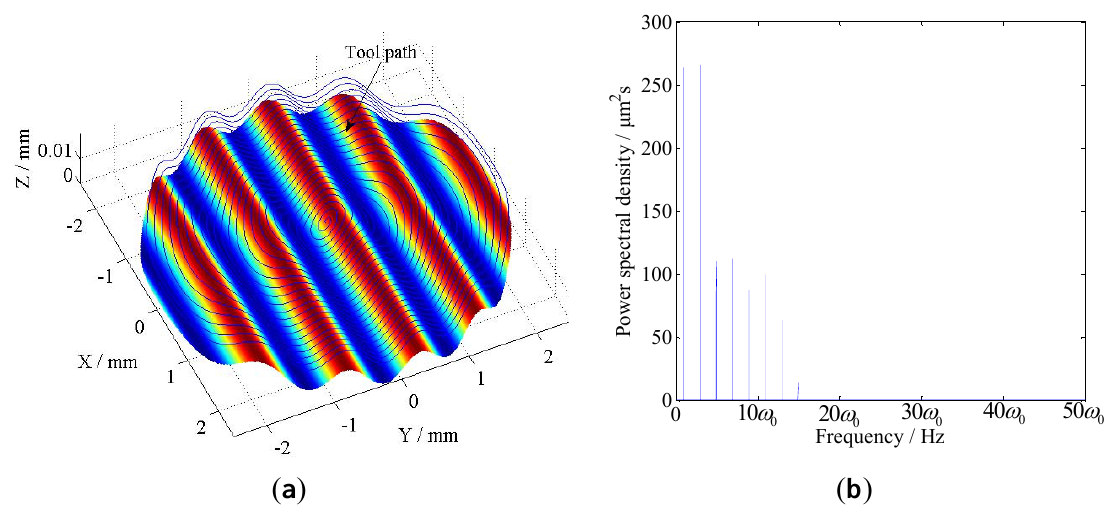
Figure 8. The sinusoidal surface and the PSD analysis of its tool path: ( a ) Schematic of the sinusoidal surface and its tool path; ( b ) PSD analysis of the tool path.